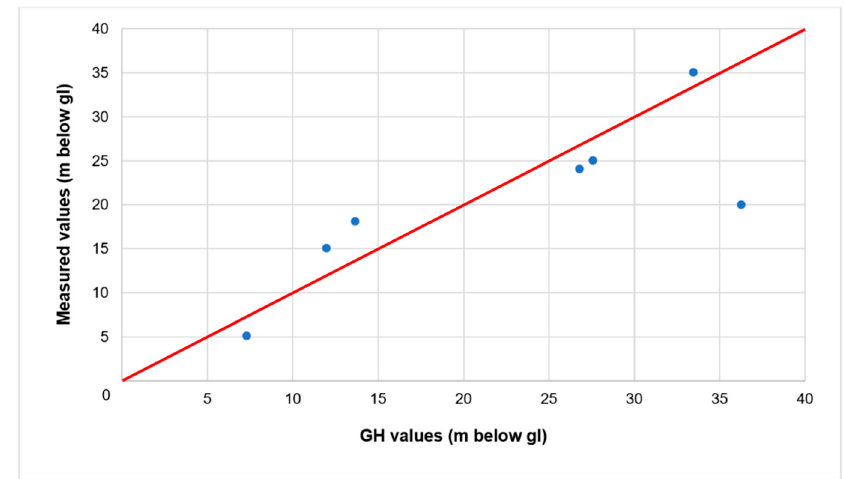
Figure 10. Depth of the seawater interface below ground level (gl) for some wells located near the coast line: values measured by means of temperature and electrical conductivity logs versus values calculated by the Ghyben–Herzberg formula (GH).